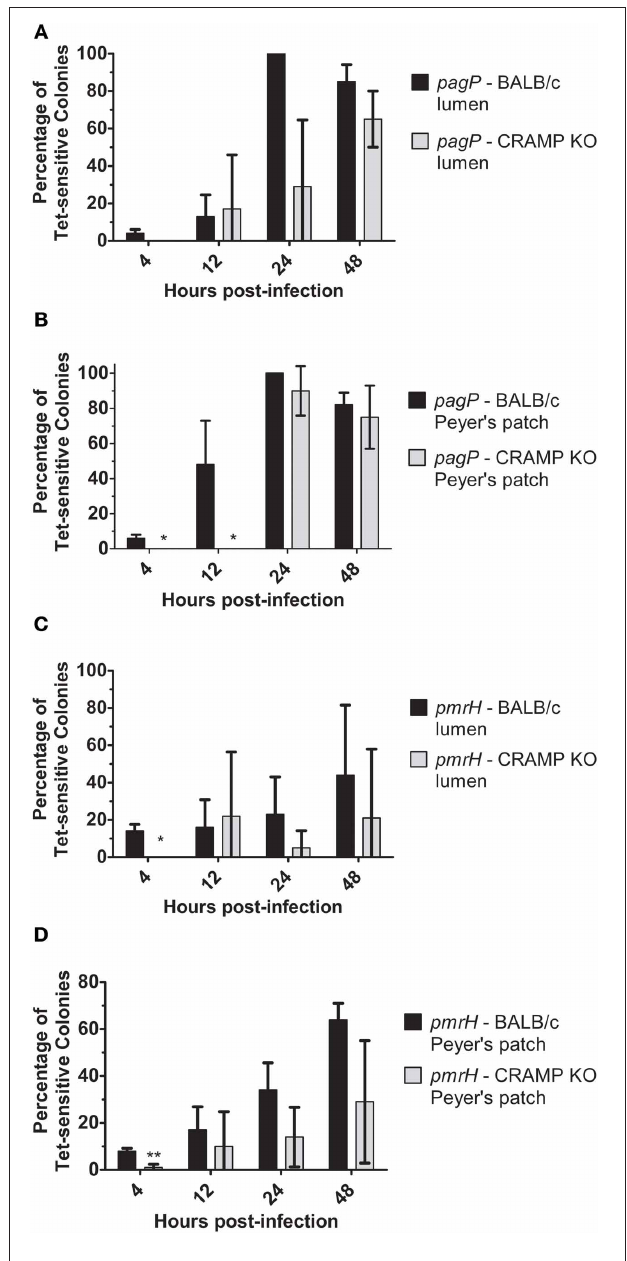
FIGURE 7 | TCRS-mediated activation of S . Typhimurium pagP and pmrH in the WT and CRAMP KO murine intestinal lumen and Peyer’s patches. BALB/c and CRAMP KO mice were infected orally with 10 8 CFU of the S. Typhimurium pagP or pmrH RIVET strains. Mice were sacrificed at 4, 12, 24 and 48h p.i. for removal of infected organs. Tissue samples were homogenized,diluted, plated on LB and grown overnight at 37 ◦ C to recover intracellular bacteria. One hundred colonies recovered from each sample were patched on LB and LB Tet to to detect loss of Tet-resistance due to promoter activation in vivo . Graphed values represent the mean percentage ± standard deviation of Tet-sensitive colonies recovered from the (A) and (C) intestinal lumen and (B) and (D ) Peyer’s patches of three BALB/c and three CRAMP KO mice infected with the pagP or pmrH RIVET strain for each time point in one representative experiment performed at least twice in triplicate. One asterisk ( ∗ ) indicates p < 0 . 005 and two asterisks ( ∗∗ ) indicate p < 0 .